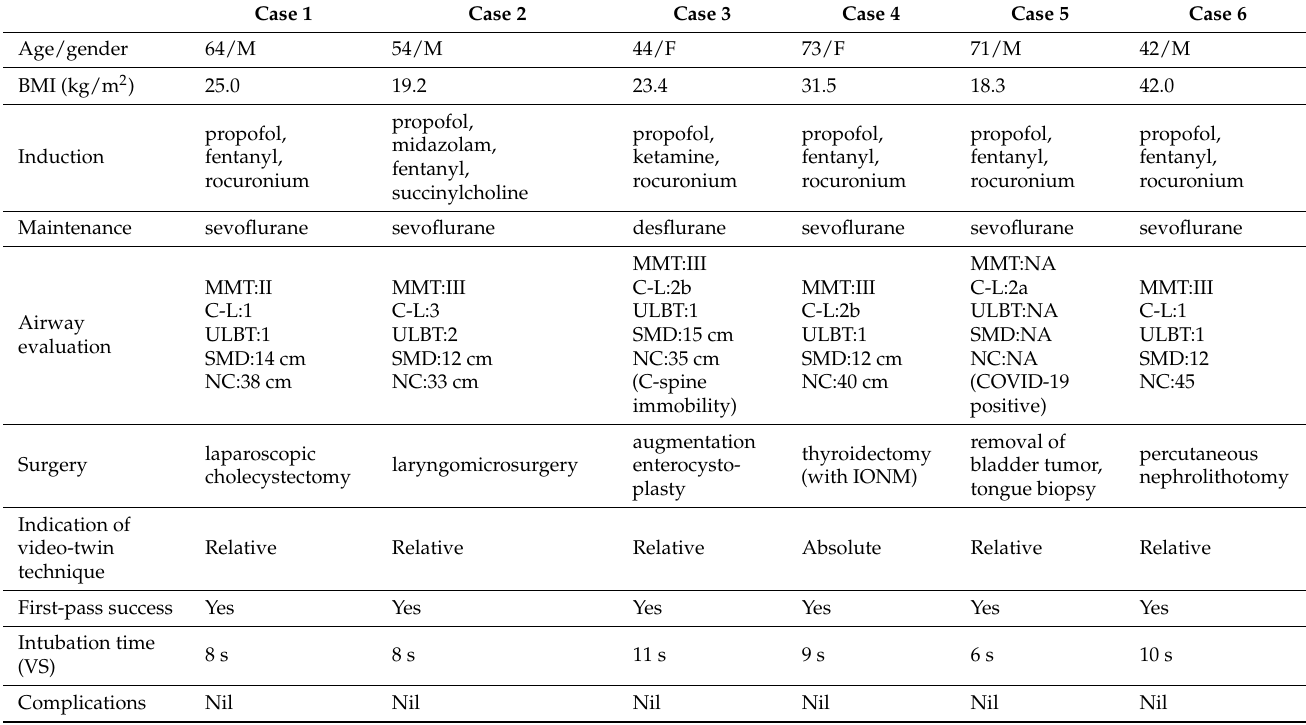
Table 1. Summary of the six